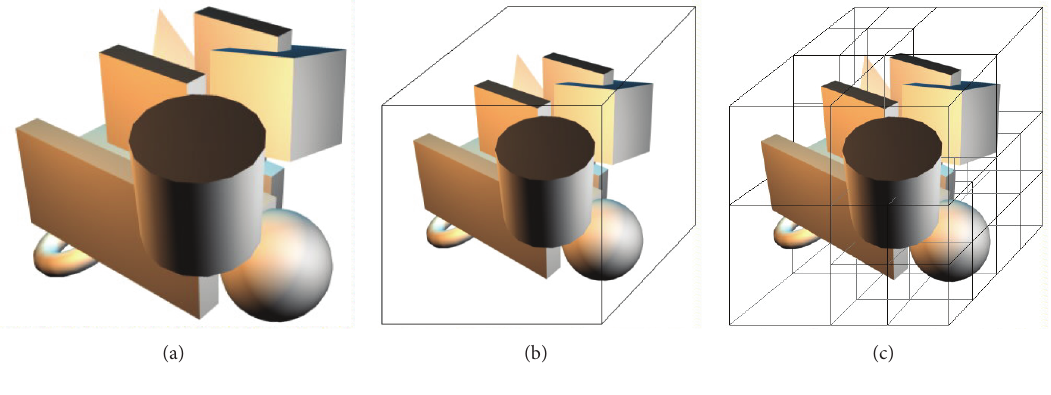
Figure 5: The creation of Octree